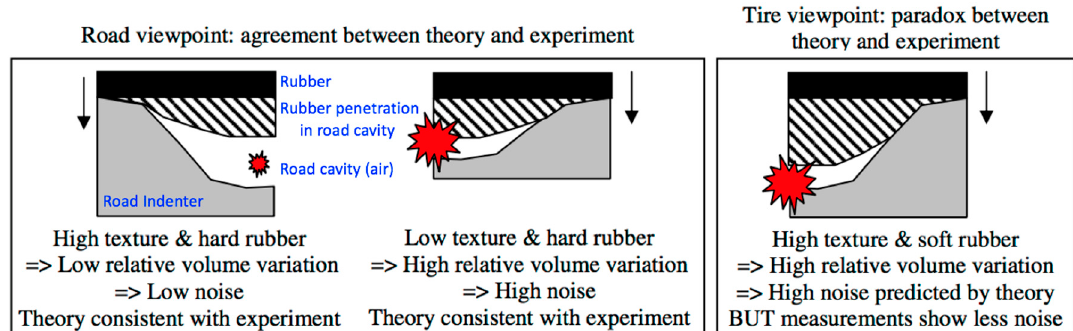
Figure 11. Commonly proposed air pumping mechanism: disagreement with measurements from the tire’s point of view (modified from Rochoux and Biesse, 2010 [113], Figure 1; reprinted under fair use provision).